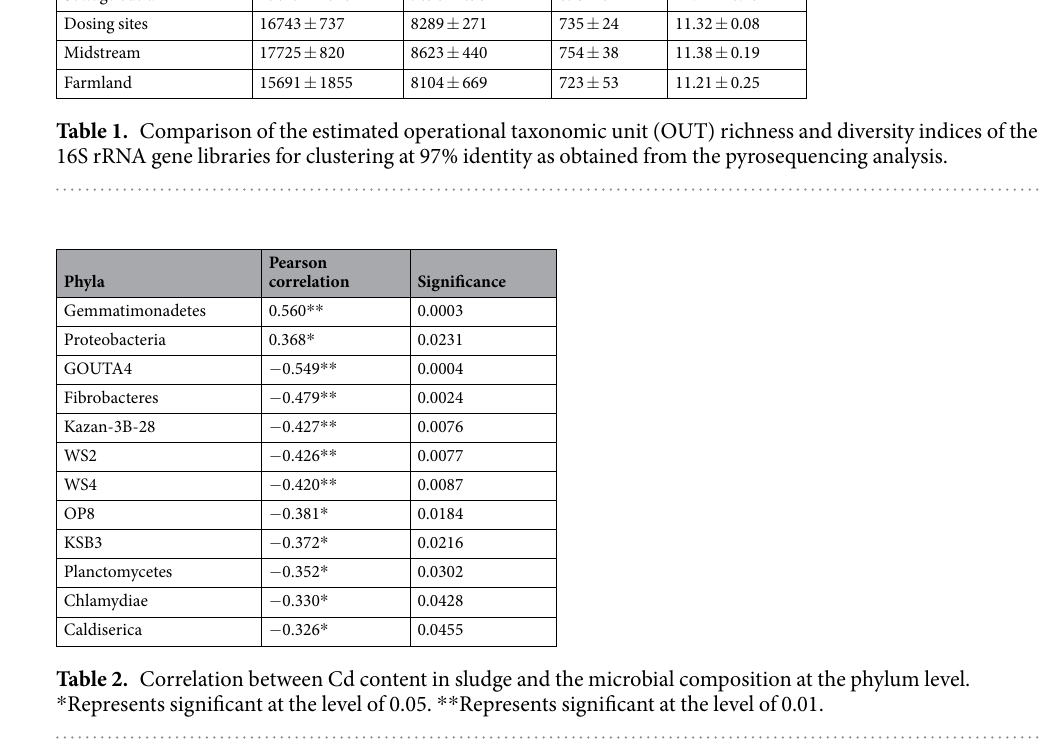
PD_whole_ tree Shannon